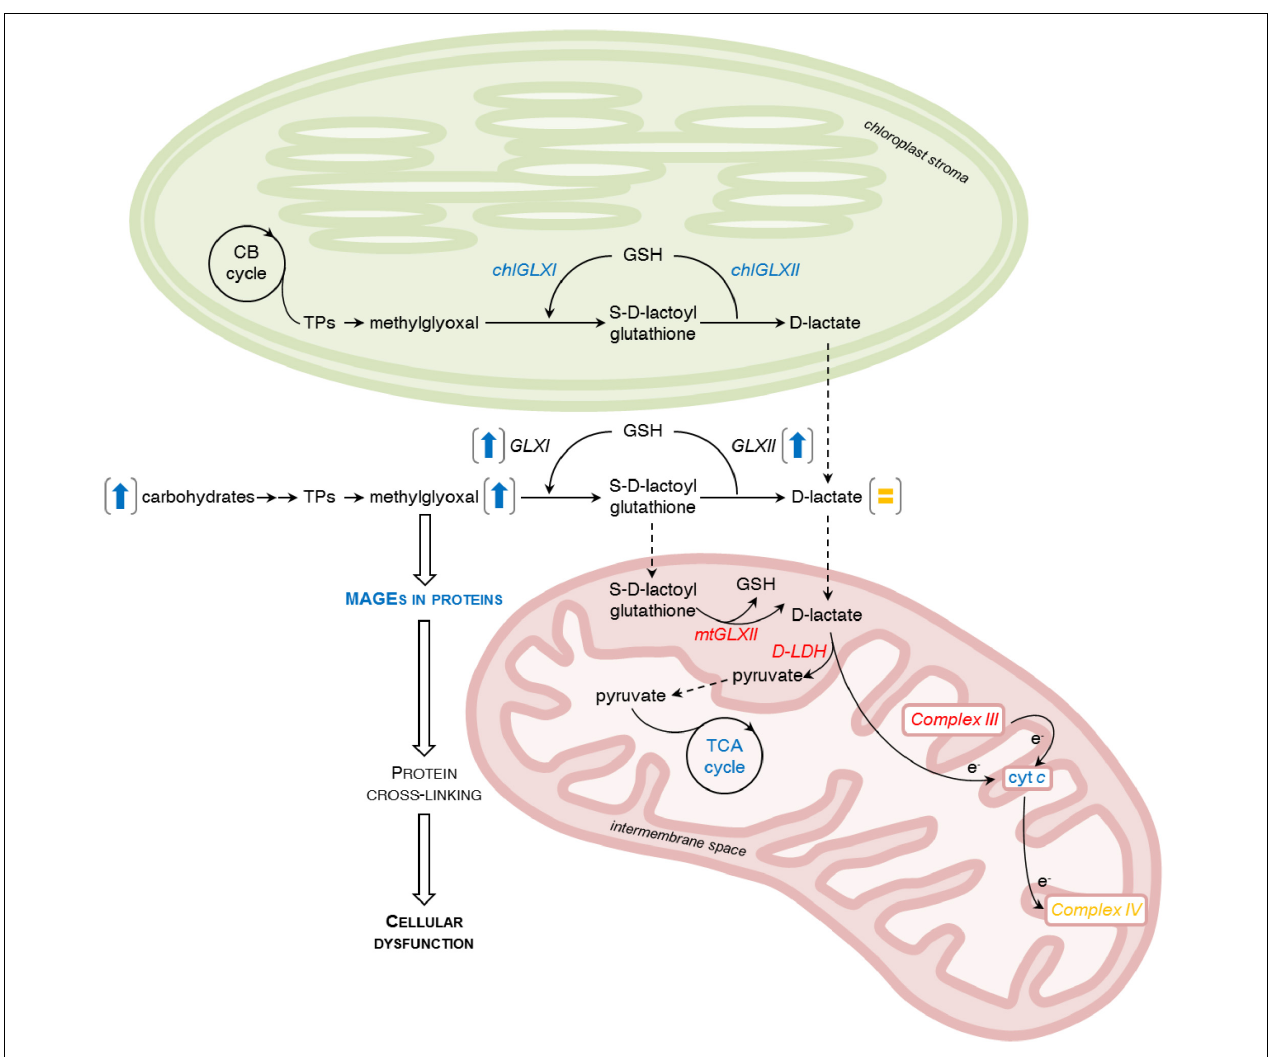
FIGURE 8 | Influence of ammonium (NH 4 + ) nutrition on methylglyoxal (MG) metabolism. MG production and accumulation are promoted by increased sugar concentration and enhanced glycolysis. MG may be produced also in chloroplasts from triose phosphate isomers (TPs) in the Calvin-Benson cycle (CB cycle). In tissue extracts, catabolism of MG in a glutathione (GSH)-dependent glyoxalase pathway comprised of glyoxalase I (GLXI) and glyoxalase II (GLXII) resulting in production of less toxic S - D -lactoylglutathione and D -lactate is enhanced. Additionally, chloroplastic isoforms of GLXI (chlGLXI) and GLXII (chlGLXII) have higher activity. In contrast, the cellular level of D -lactate remains stable. Mitochondrial metabolism of the MG-intermediates catabolic pathway is down-regulated. Mitochondrial glyoxalase II (mtGLXII) activity decreases. D -lactate is subsequently converted to pyruvate through the activity of mitochondrial D -lactate dehydrogenase ( D -LDH) and electrons are transferred to the respiratory chain through cytochrome c (cyt c ). In NH 4 + -grown plants, D -LDH activity is decreased, but not due to the low availability of the oxidized form of cytochrome c because cyt c protein levels in those plants are higher. Additionally, Complex III activity decreases and Complex IV activity remains stable. Pyruvate produced by D -LDH enters into the tricarboxylic acid (TCA) cycle that is enhanced to meet the demand of carbon skeletons for NH 4 + assimilation. Over-accumulation of MG in the cell leads to formation of MG-derived advanced glycation end products (MAGEs). Modified proteins usually undergo structural and functional impairment that causes cellular dysfunction and mediates NH 4 + toxicity. The difference in enzyme activities or metabolite levels between NH 4 + -grown and NO 3 − -grown plants are indicated by colors; increases are marked with blue, decreases with red, and lack of change with yellow letters. Results for whole leaf tissue extracts are presented in brackets as arrows (increases are marked with blue) or the equal sign (lack of change is marked with